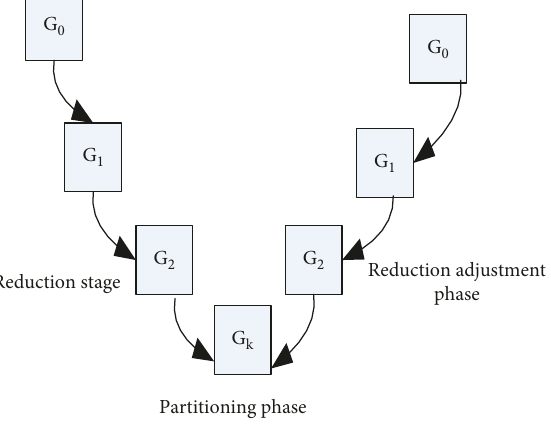
Figure 1: Transformer branch network.